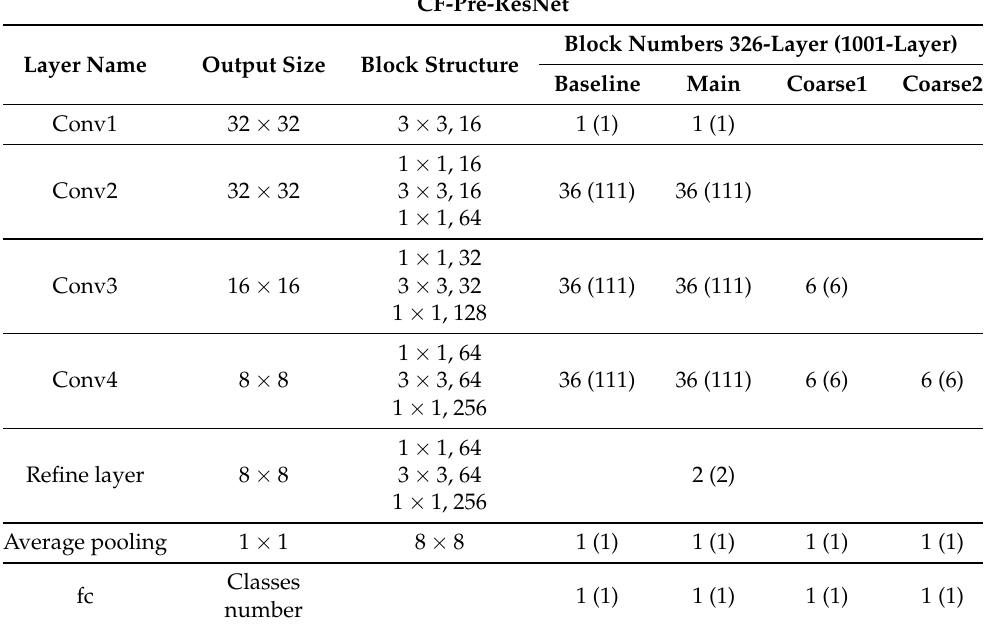
Table 3. Structure of the CF-Pre-ResNet model for CIFAR-10 and CIFAR-100 datasets.